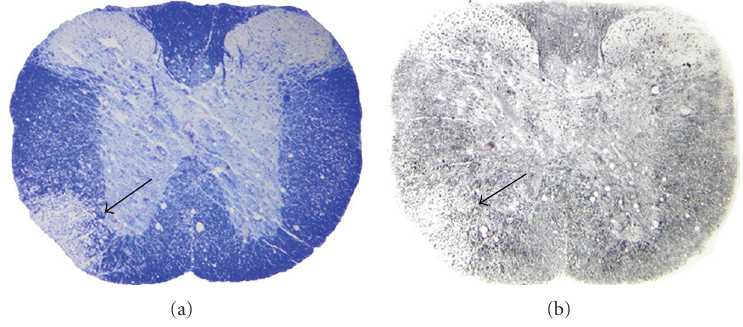
Figure 3: Demyelination and axonal loss in a neurotropic strain of MHV, MHV-A59-infected mouse spinal cord. Serial cross-sections (5 μ m thick) from MHV-A59-infected mouse spinal cord at day 7 p.i. were stained for myelin with LFB or by Bielchowsky silver impregnation. (a) A large demyelinating plaque observed in MHV-A59-infected mouse spinal cord is shown (arrow indicates demyelinated area). (b) In an adjacent section, the same demyelinating plaque of MHV-A59-infected spinal cord shows loss of axons (arrow indicates area of axonal loss) (adapted from the work of